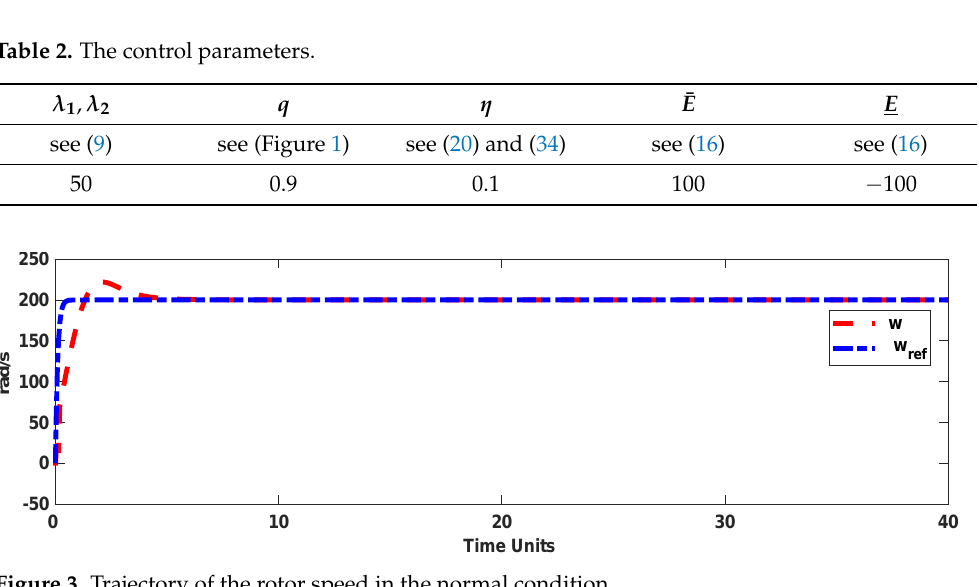
Figure 3. Trajectory of the rotor speed in the normal condition.